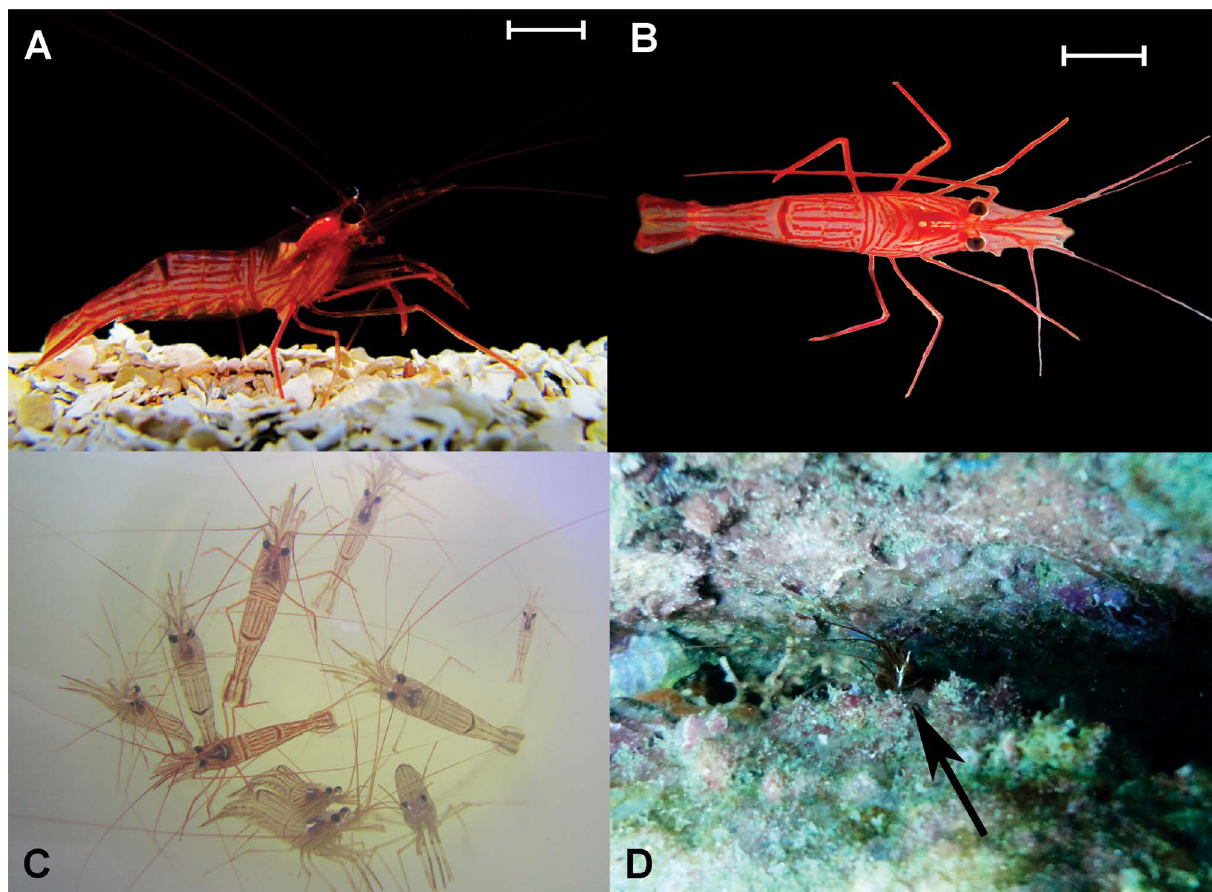
Figure 1. Lysmata ankeri. (A) Lateral view; (B) dorsal view; (C) some specimens in the laboratory after sampling; (D) an individual (indicated by the arrow) in rock crevice at the sampling site, on the subtidal rocky bottom at Couves Island, Ubatuba, Brazil (Photographs: DFR Alves). Scale bars = 5